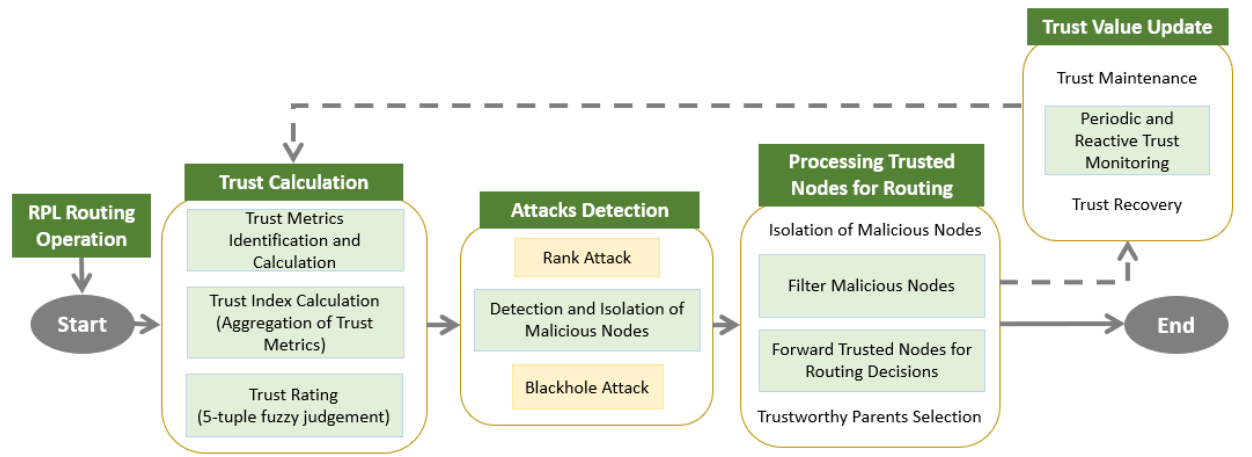
Figure 4. Flow Diagram of SMTrust.